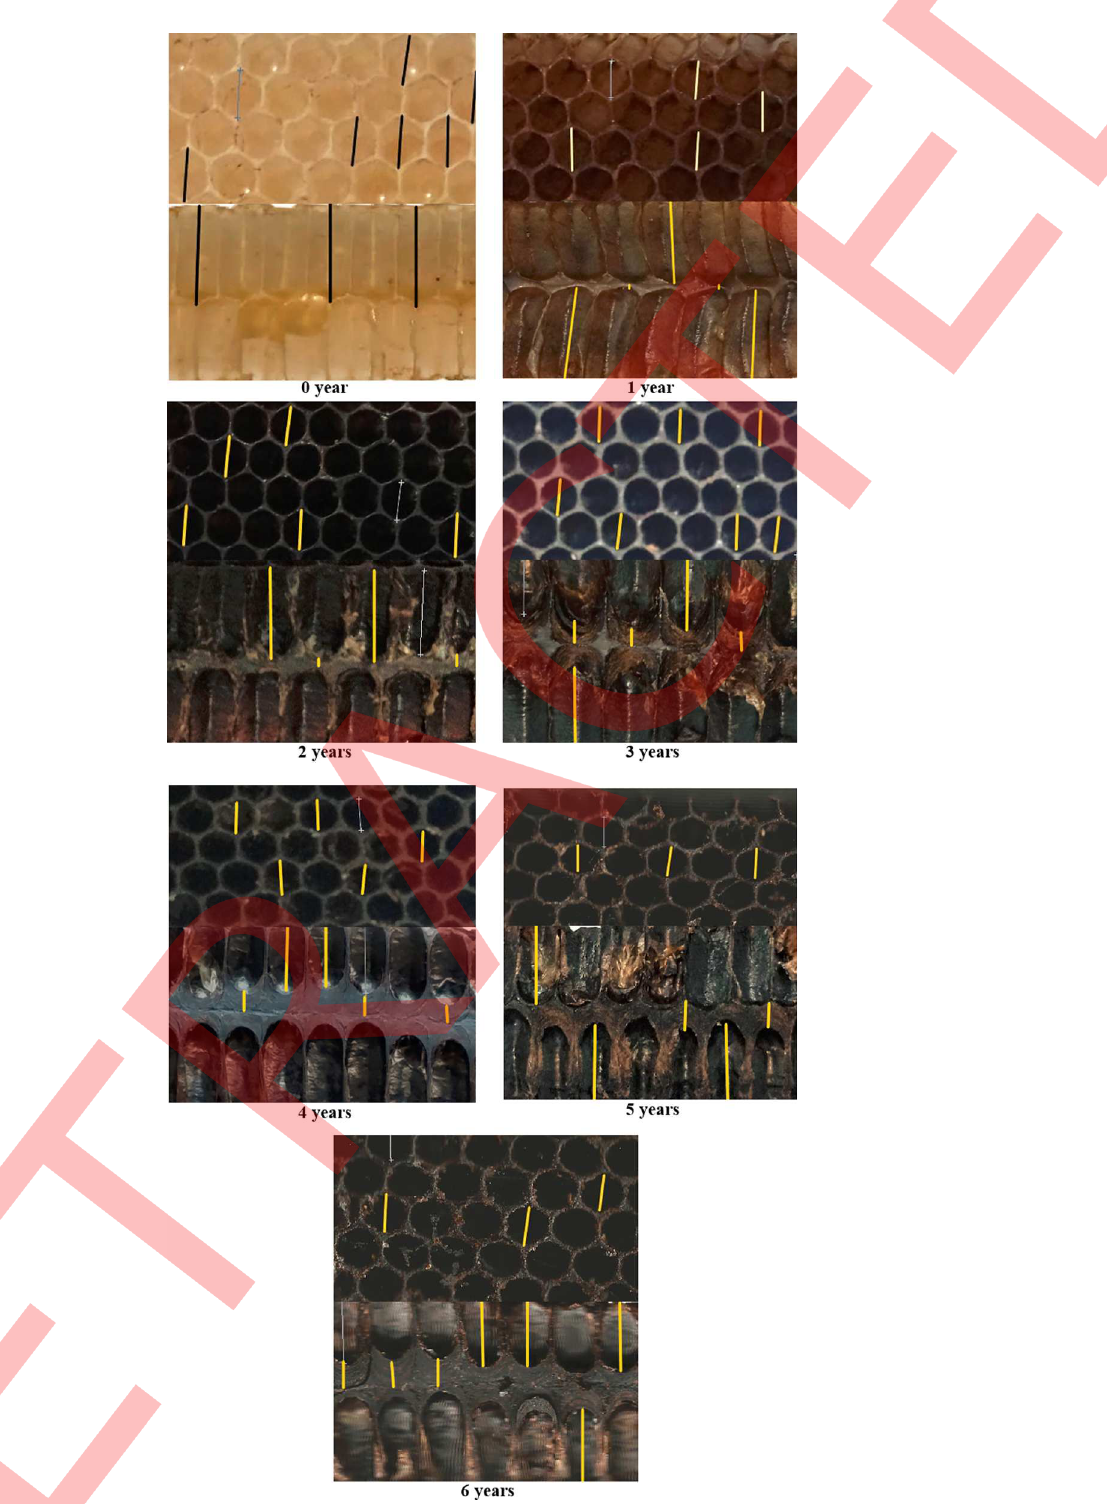
Fig 1. Cell diameter, cell depth, and cell base height in combs of different ages.